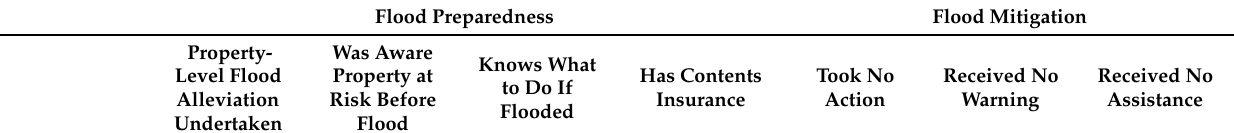
Table 5. Multivariate models of factors associated with flood resilience—households who lived in the property at time of flood event. (Odds ratios).